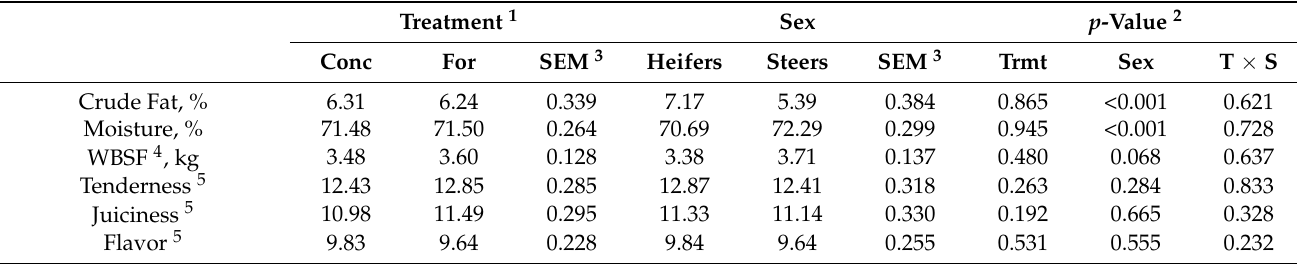
Table 6. Least square means for meat characteristics of progeny from dams fed a prepartum dietary carbohydrate source consisting of concentrate-based (Conc) or forage-based (For) diet during mid- and